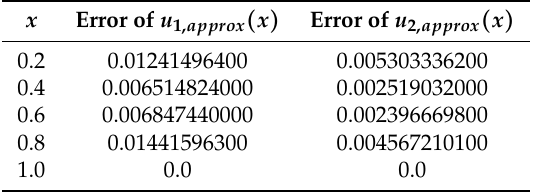
Table 5. The absolute error of the this method for Example